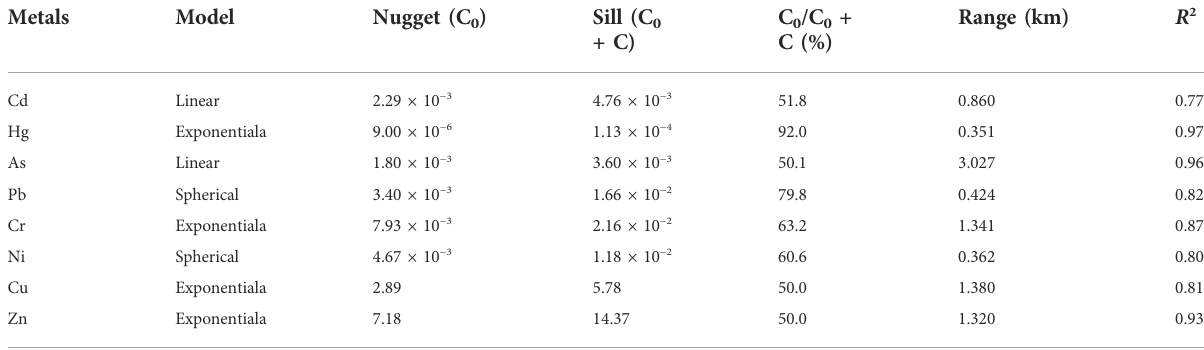
TABLE 3 Semivariogram fi tting model and parameters of heavy metals in